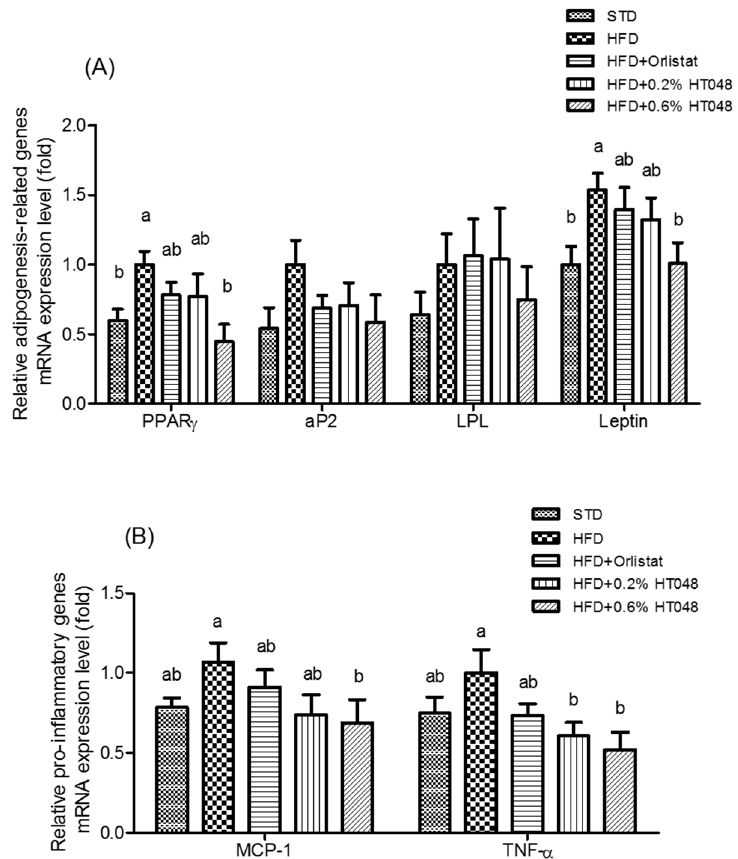
Figure 3. Effect of HT048 on mRNA expression of genes related to WAT adipogenesis ( A ) and pro-inflammatory ( B ) in HFD-fed obese rats. Values are mean ± SD ( n = 12 for each group). Data were analyzed by one-way analysis of variance (ANOVA) followed by Duncan’s multiple range test. ab Means not sharing common letters are significantly different among the groups at p < 0.05.